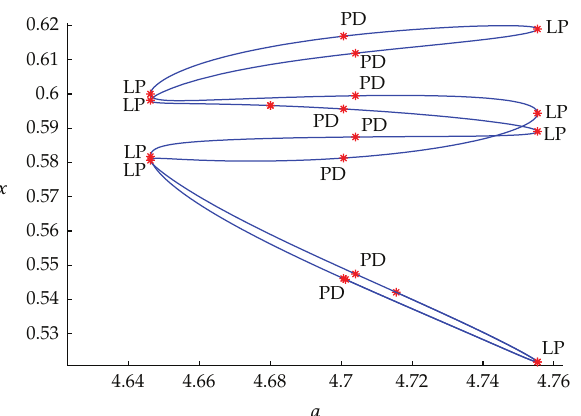
Figure 13: Curve of fixed points of the sixteenth iterate starting from the 16-cycle C 16 .